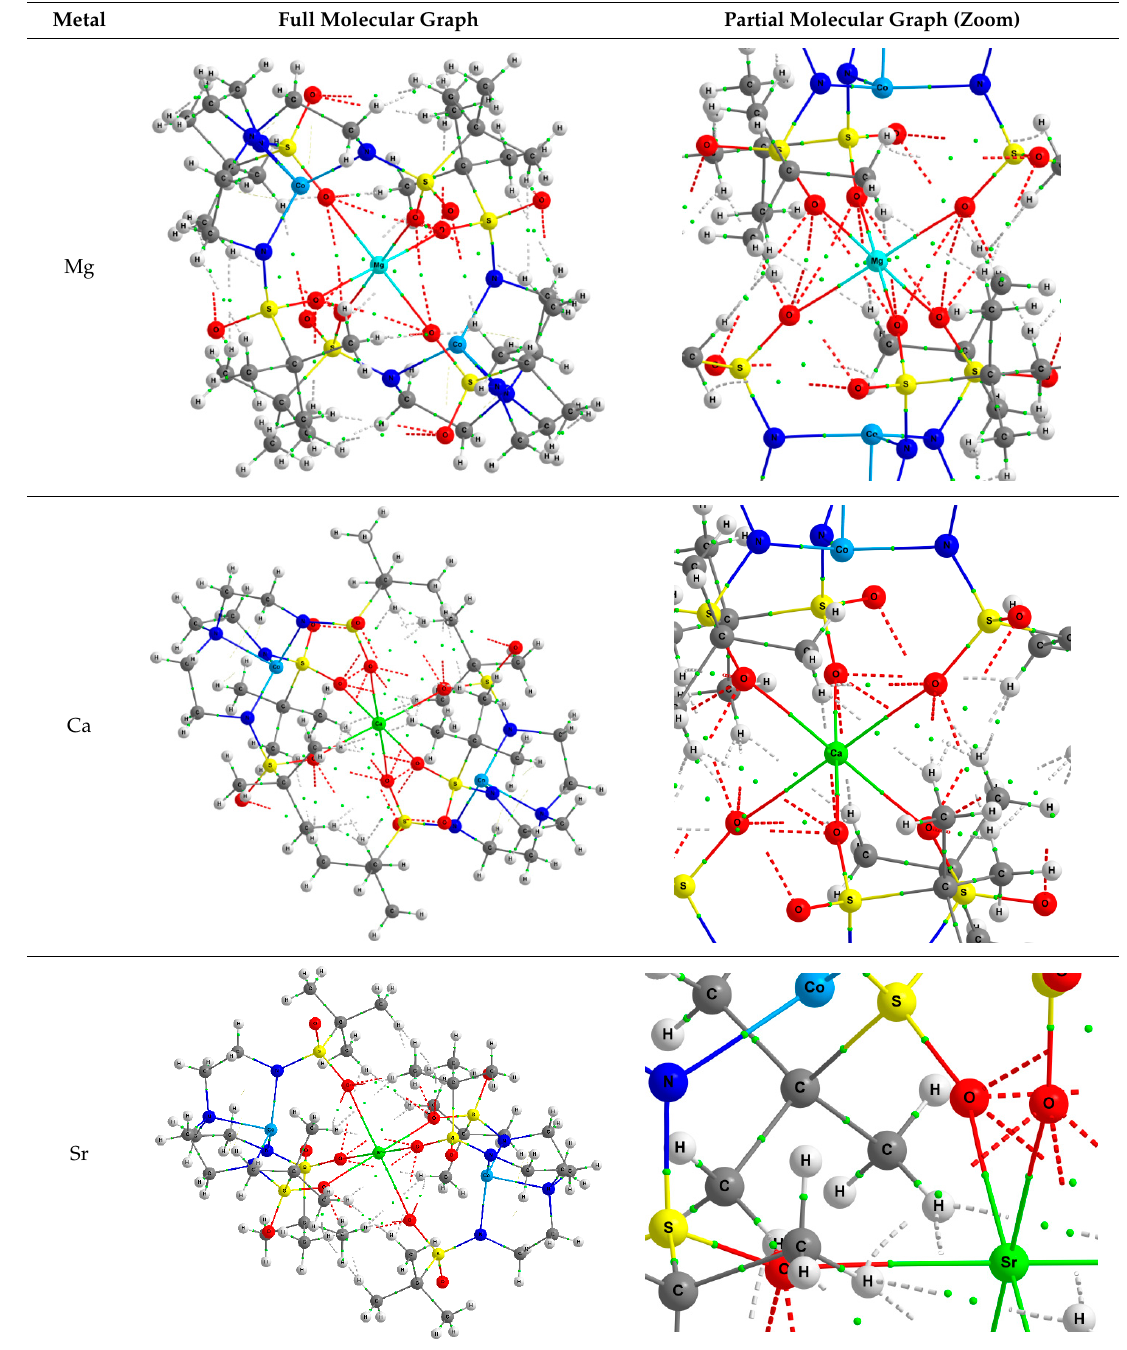
Table 1. Molecular graph of the complexes.